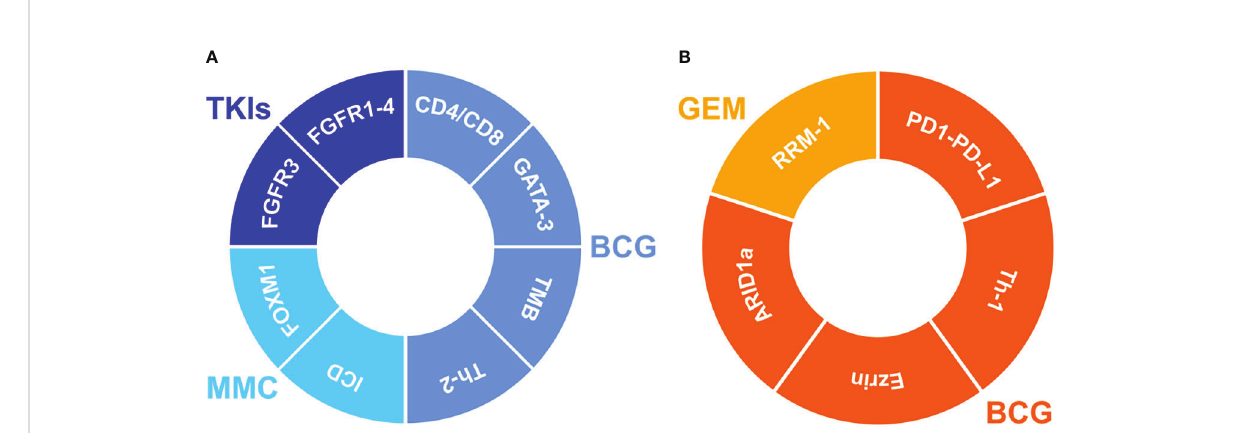
FIGURE 3 Impact of the predictive biomarkers on the clinical outcome in NMIBC. Markers improving the tumor outcome (A) during treatment with BCG (bacillus Calmette-Gue ́ rin), MMC (mitomycin C) or TKIs (tyrosine kinase inhibitors). Markers worsening the tumor outcome (B) during treatment with BCG or GEM (Gemcitabine). FGFR3, fi broblast growth factor receptor 3; FGFR1-4, fi broblast epidermal growth factor receptor 1-4; CD4/ CD8, CD4/CD8 T-Lymphocytes; GATA-3, GATA binding protein 3; TMB, Tumor Mutational Burden; Th-2, T helper-2 lymphocytes; ICD, mitochondria-mediated immunogenic cell death; FOXM1, Forkhead Box M1; RRM-1, ribonucleotide reductase subunit M1; PD1-PD-L1, Programmed Cell Death Protein 1/Programmed death-ligand 1; Th-1, T helper-1 lymphocytes; ARID1a, AT-rich interactive domain-containing protein